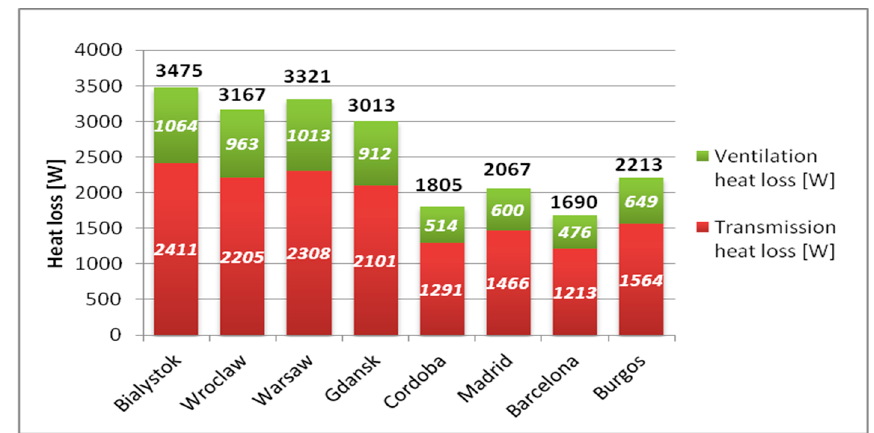
Figure 3. Comparison of the total design heat loss in different